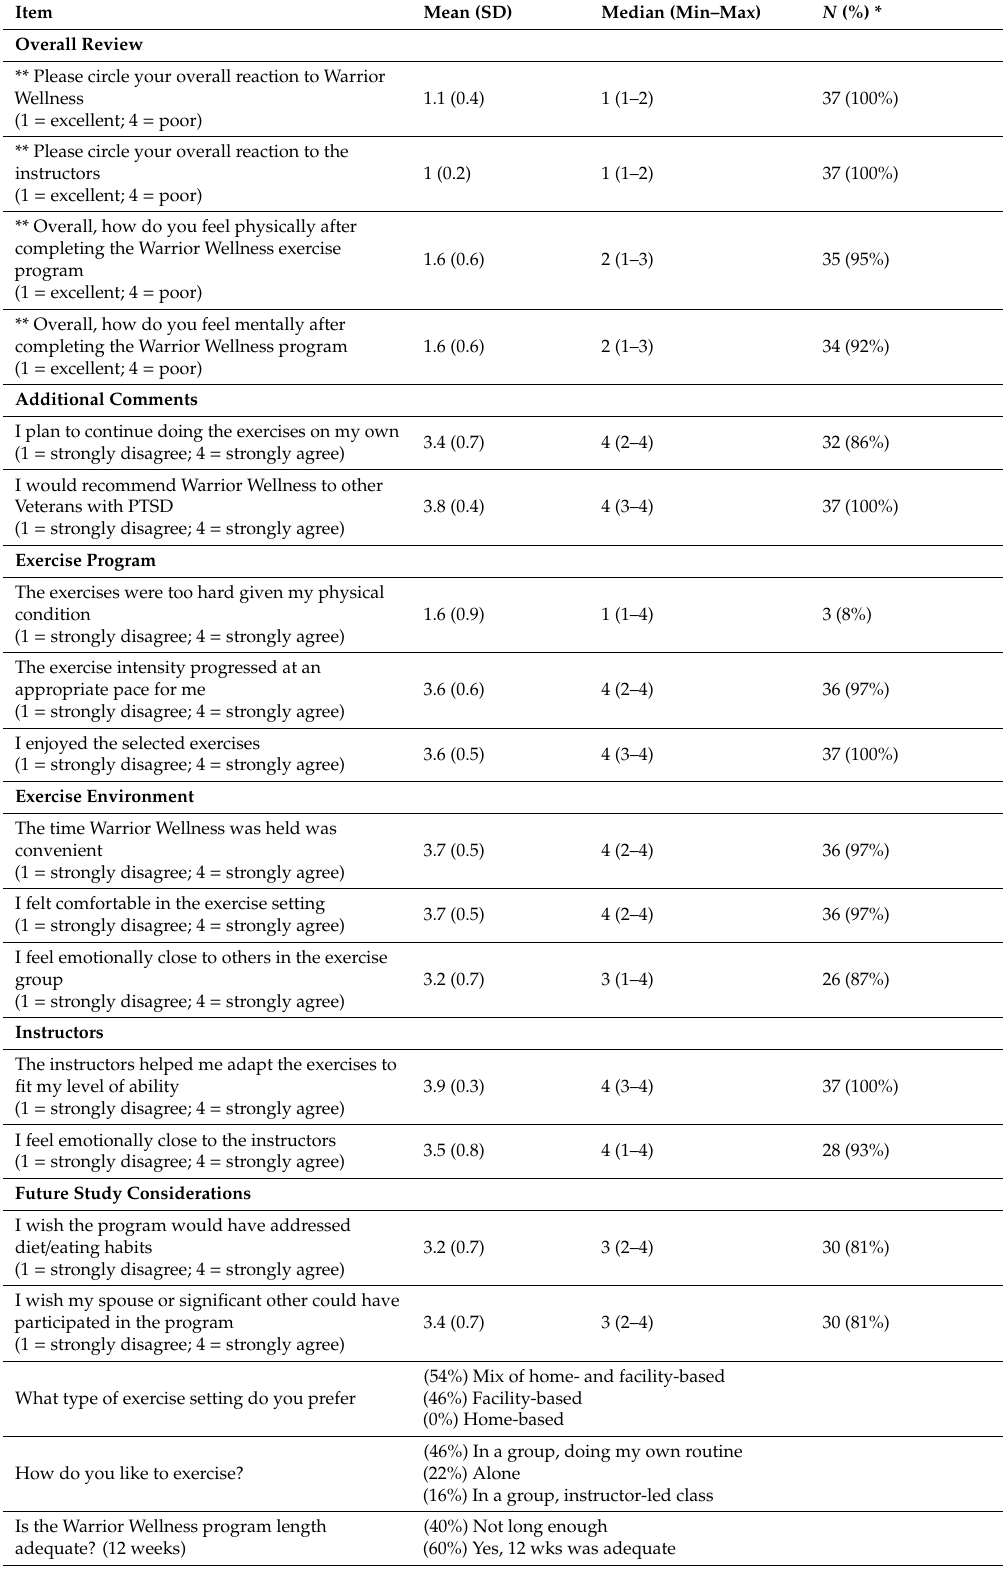
Table 2. Responses to Program